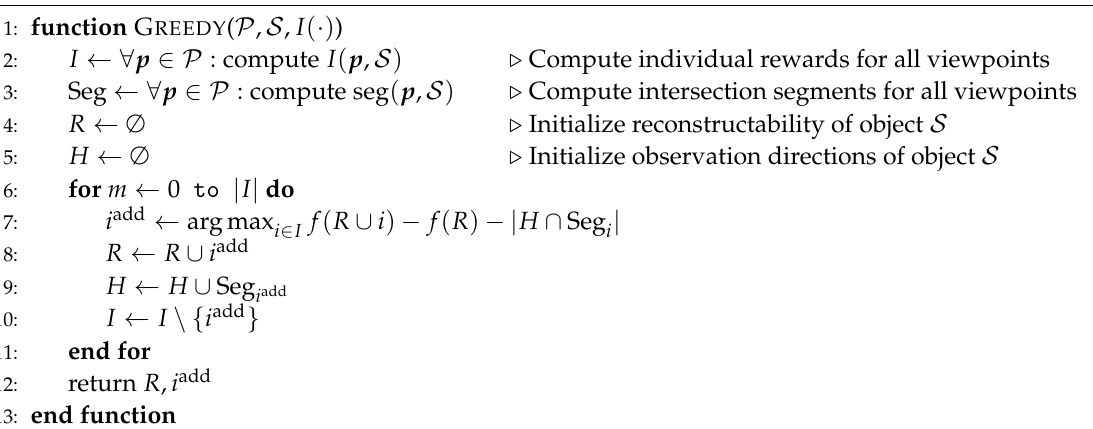
Algorithm 1 The greedy method for maximizing a monotone submodular